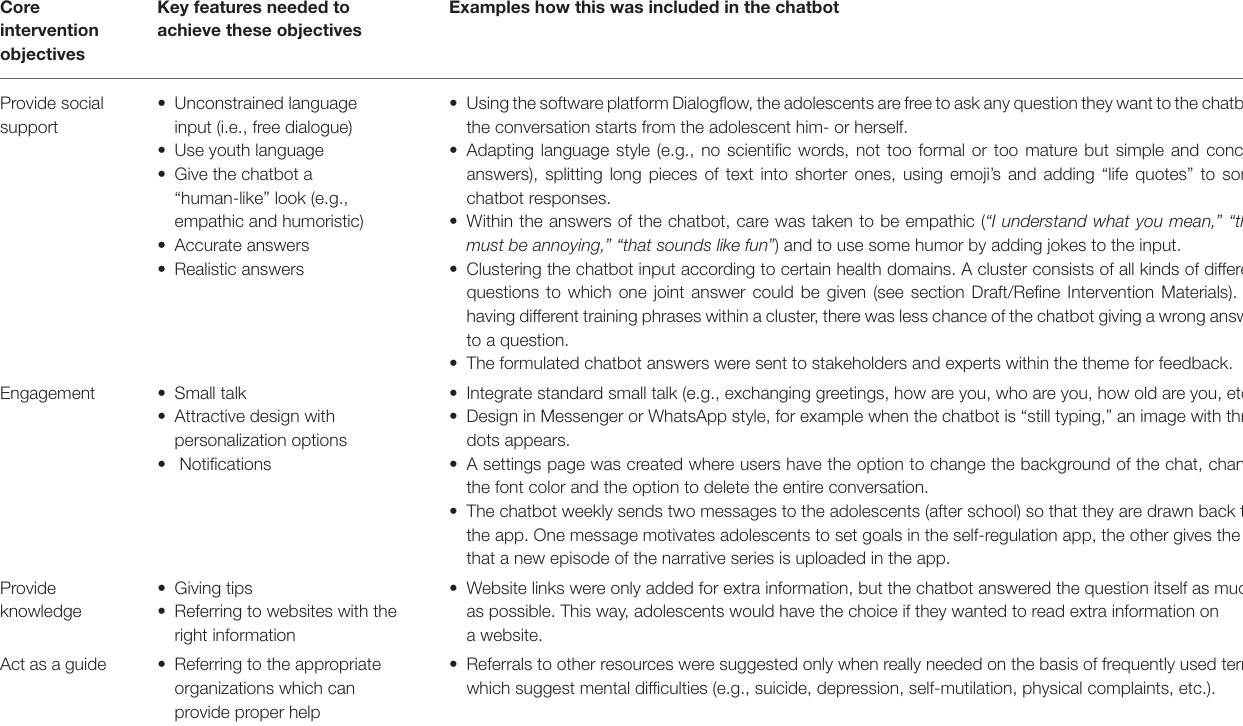
TABLE 4 | Guiding principles and examples of how these were integrated in the chatbot prototype. Core intervention